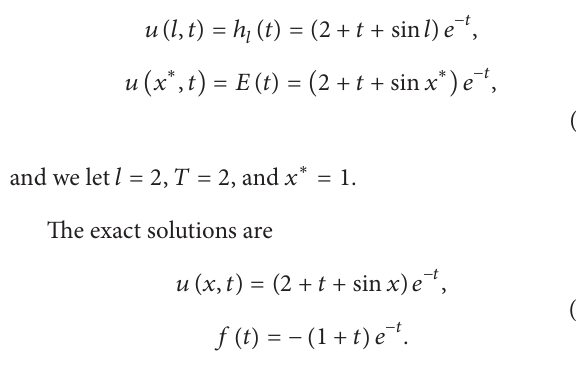
Figure 12: The exact solution 𝑓(𝑡) and the numerical solution of